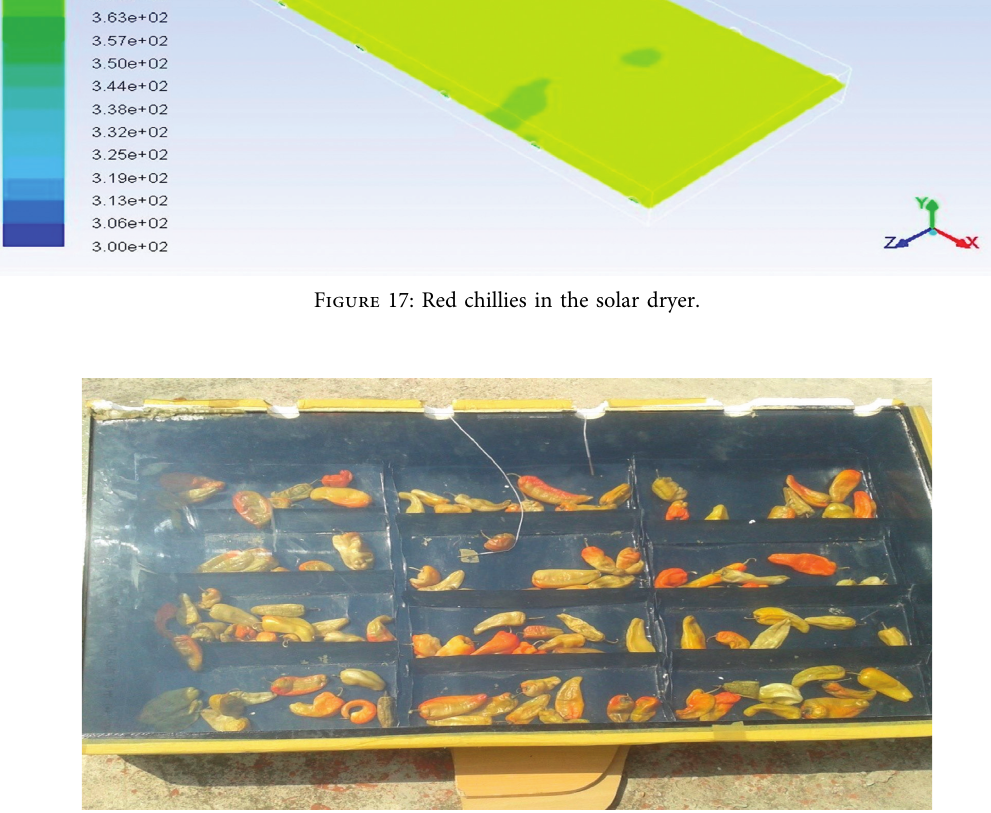
Figure 18: Effect of the solar dryer at the temperature of 40 ° C after 6